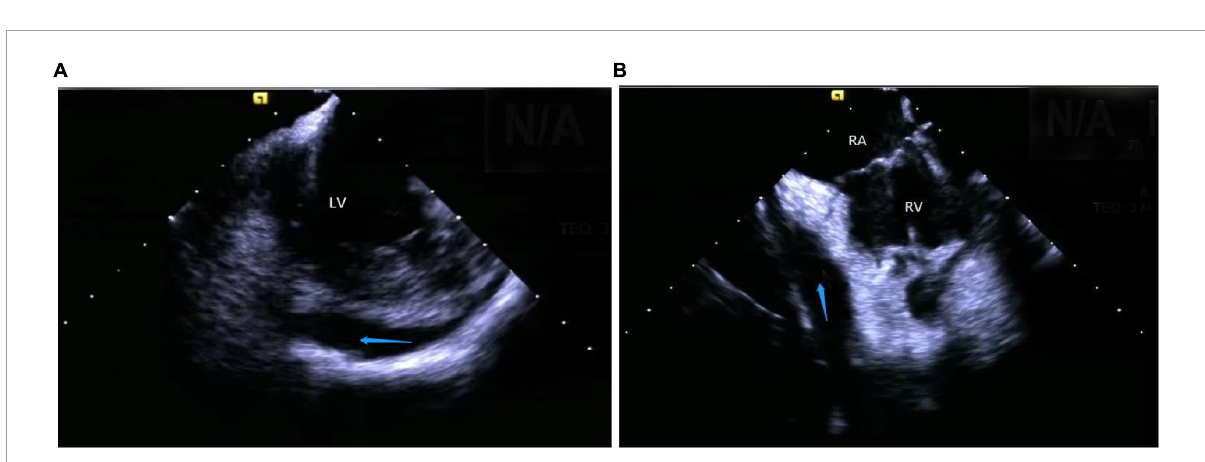
FIGURE11 Still frame of pericardial effusion occurring during a catheter intervention under ICE. (A) Left ventricular pericardial effusion. (B) Right ventricular pericardial effusion. LV, left ventricular; RV, right ventricular; RA, right atrial; Blue arrow, the positions of the pericardial